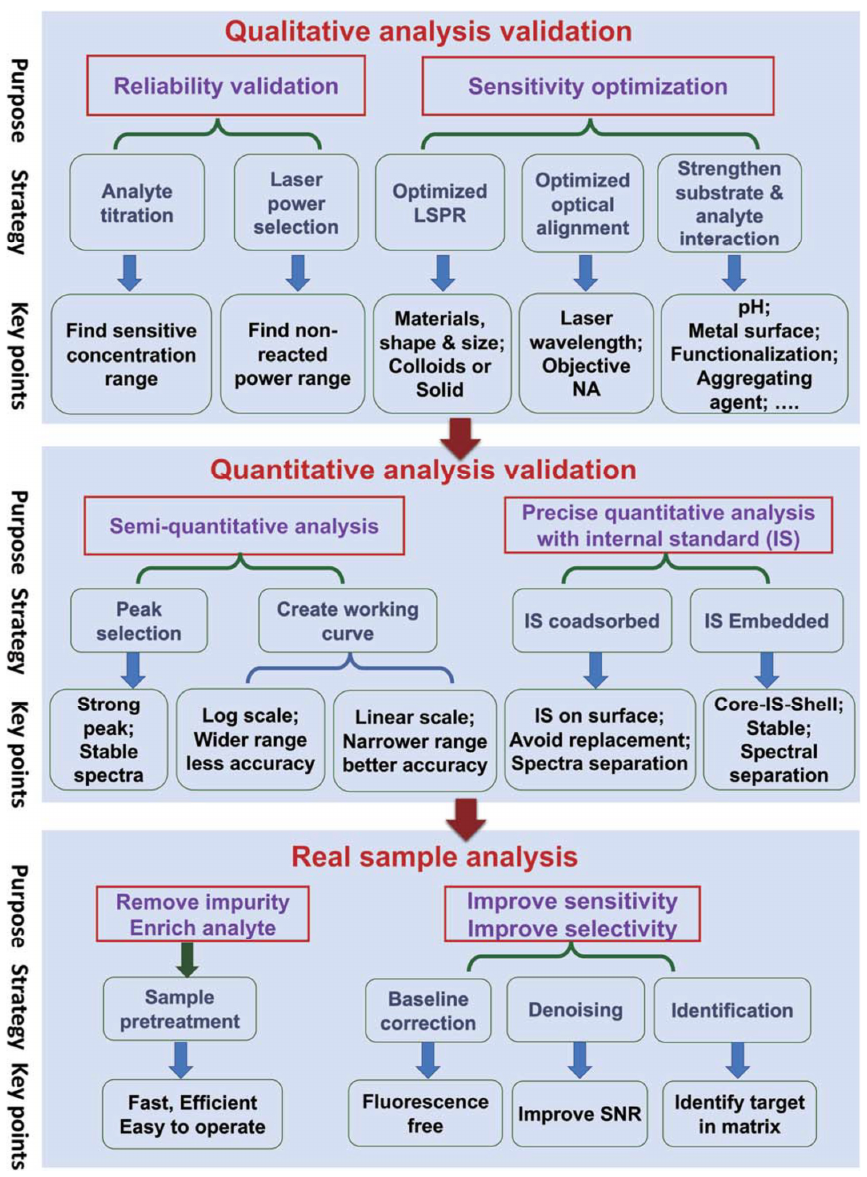
Figure 11. Steps for best practices for quantitative and qualitative detection using SERS to overcome the challenges at each stage with a goal of real-world applications. Reproduced with permission from [390]. Copyright (2020), RSC.